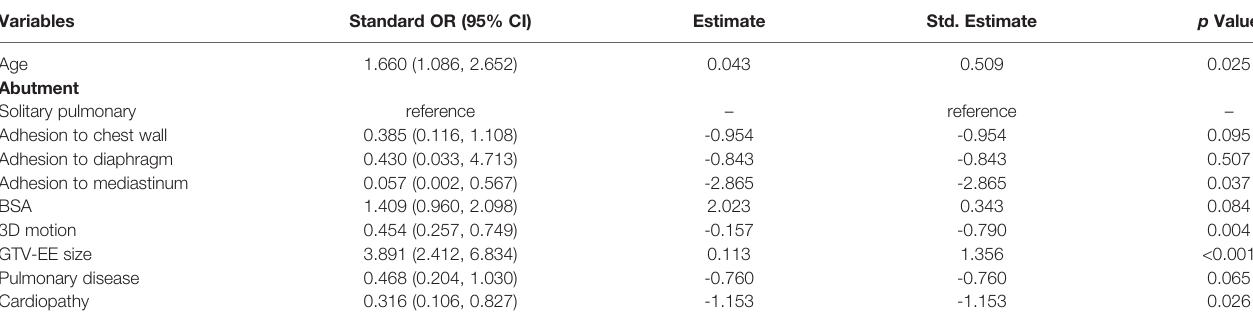
TABLE 3 | Odds ratios and 95% con fi dence intervals of DSC (IGTV-CBCT, IGTV-10).